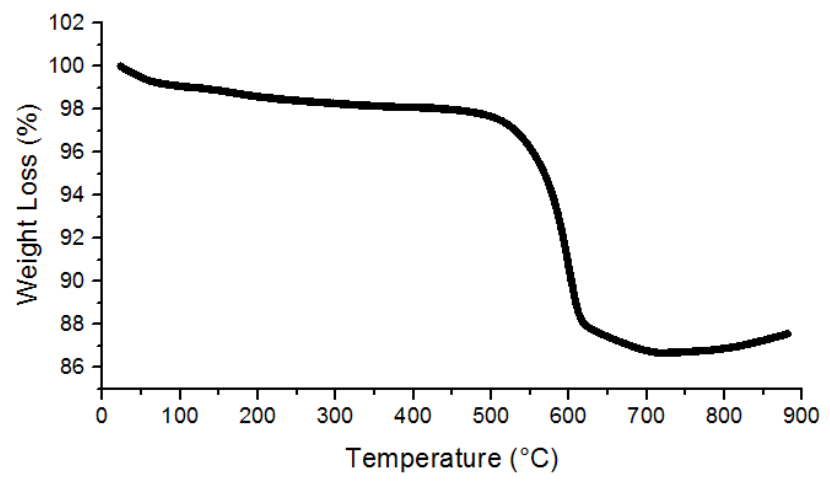
Figure A5. TGA curve of UiO-66 particles.